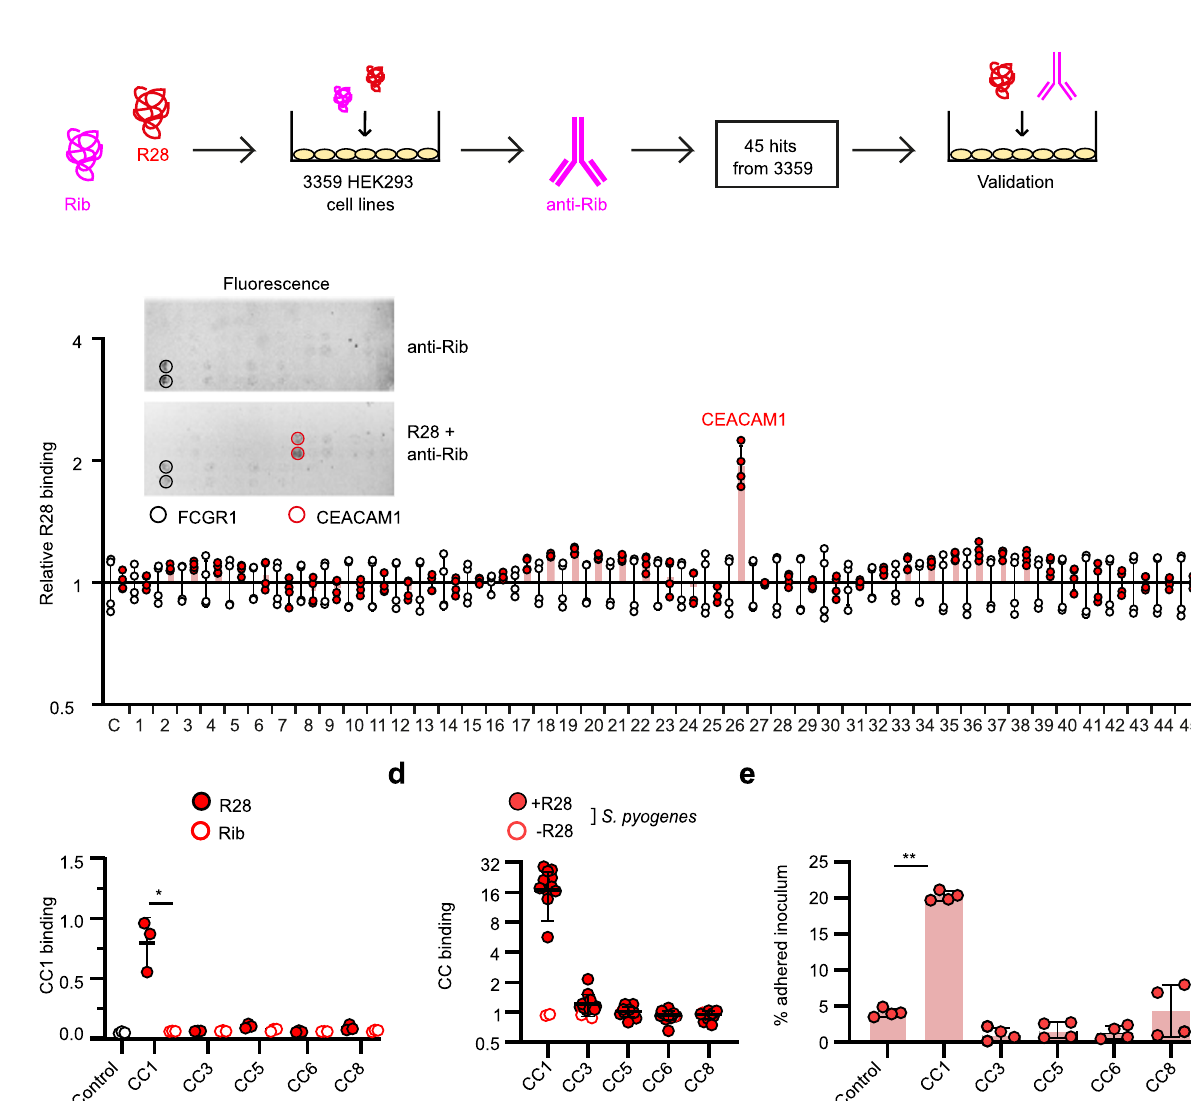
quanti fi ed by ELISA (Mean±s.d. of n =3 independent experiments).